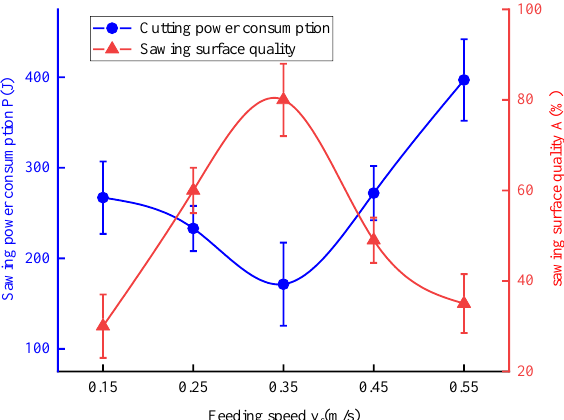
Figure 8. Sawing effect with different feeding speeds (Note: Branch diameter 10~12 mm; sawing speed